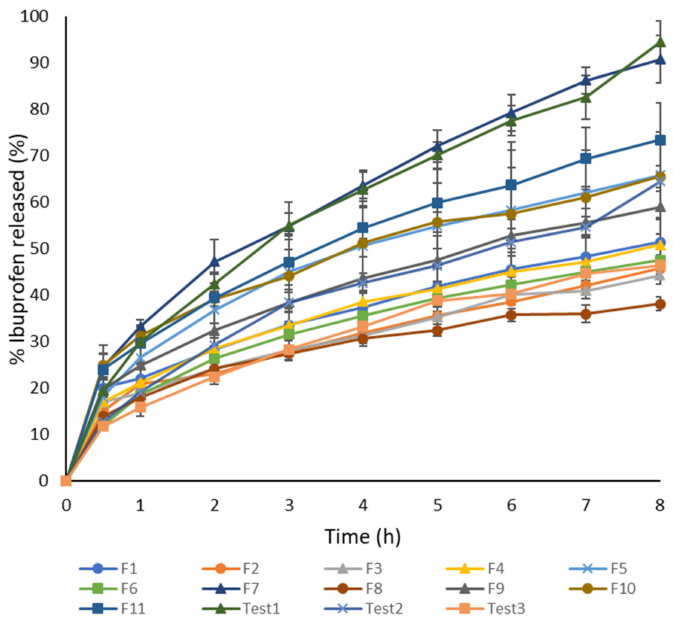
Figure 3. Dissolution profiles of ibuprofen printlets F1–F11 and Test 1–Test 3, ∆ exposure time 400 s,